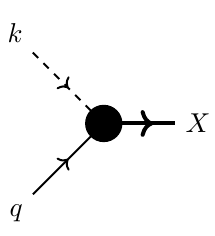
Figure 8 . Feynman diagram corresponding to a Born-level quark-initiated hard process.